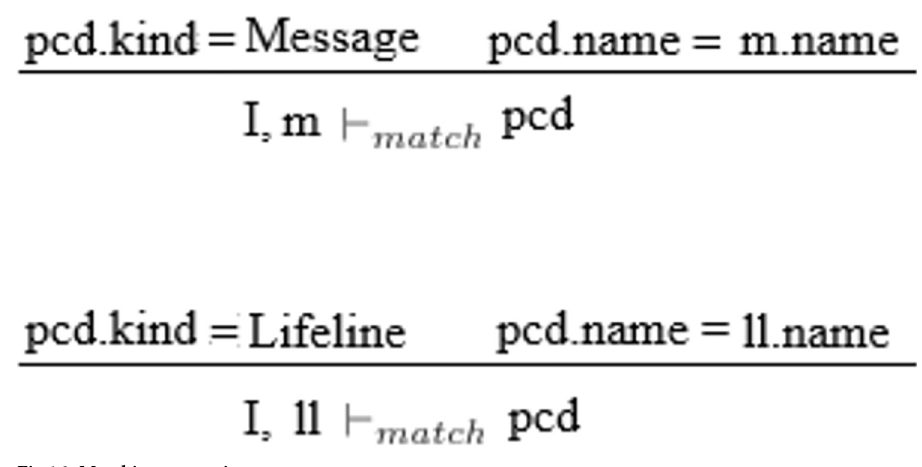
Fig 16. Matching